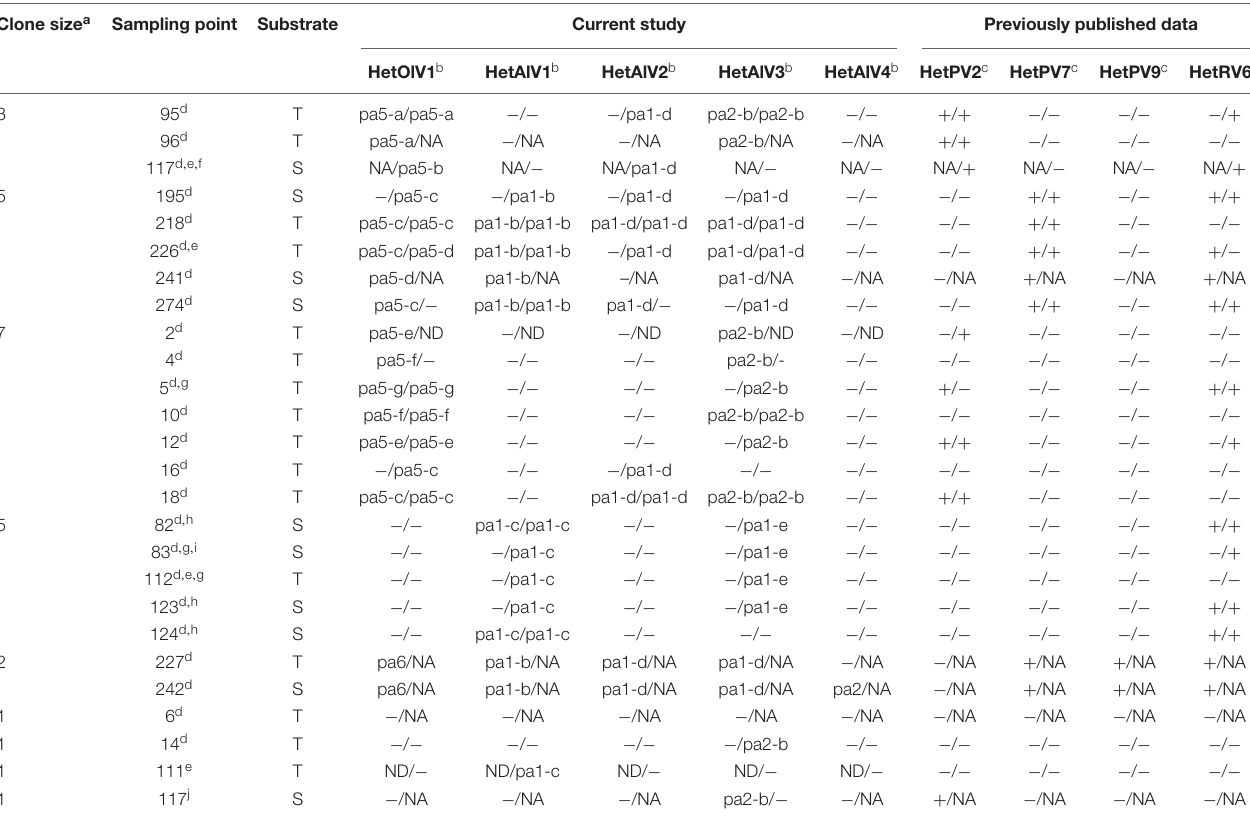
TABLE 3 | Summary of the virus infection status of H. parviporum strains and virus variants and strains of 7R field site. Clone size a Sampling point